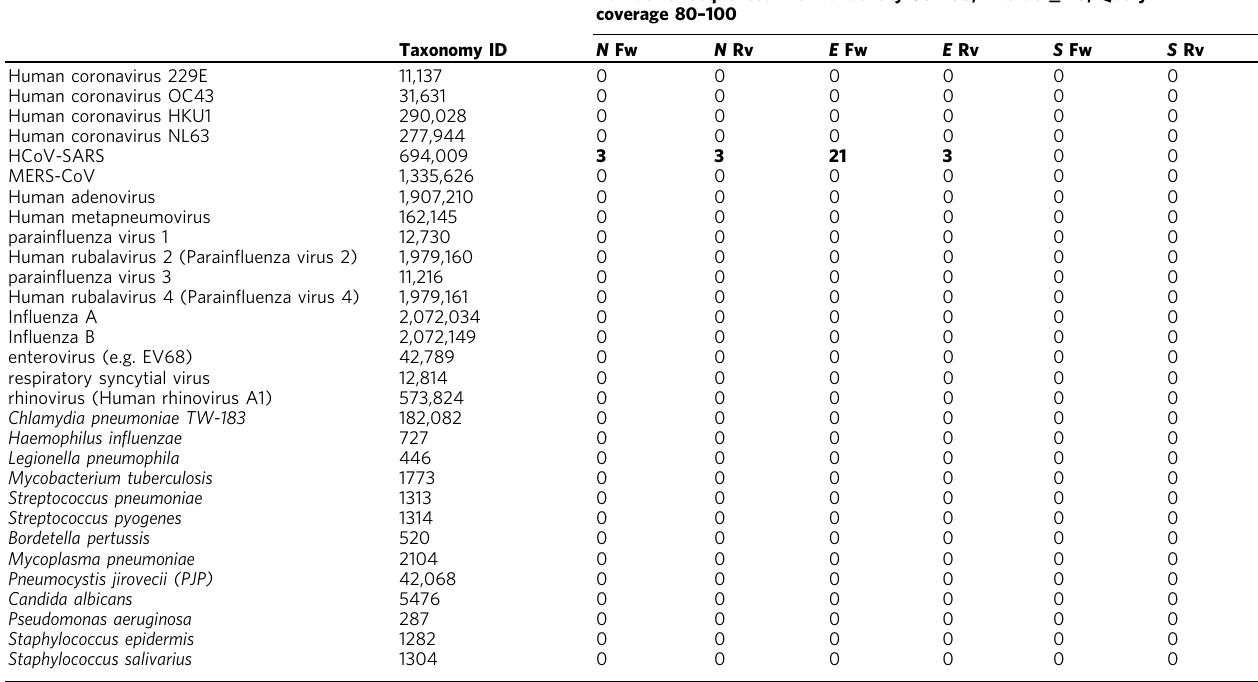
Bold entries in table aim at highlighting the